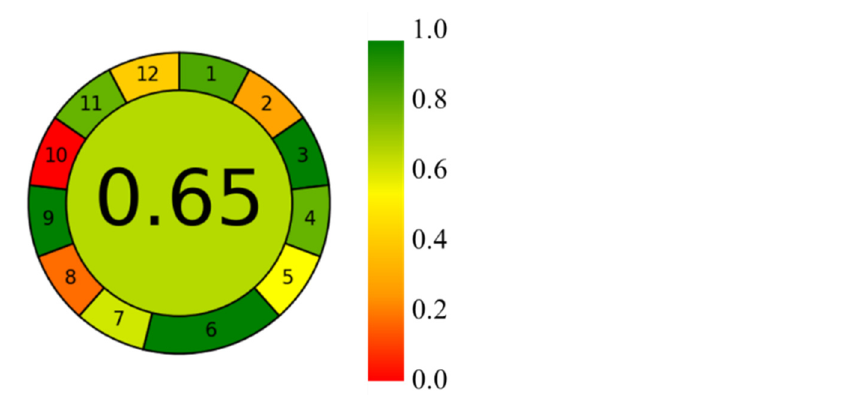
Figure 7. Assessment results of the AGREE-analysis software of the present [81].